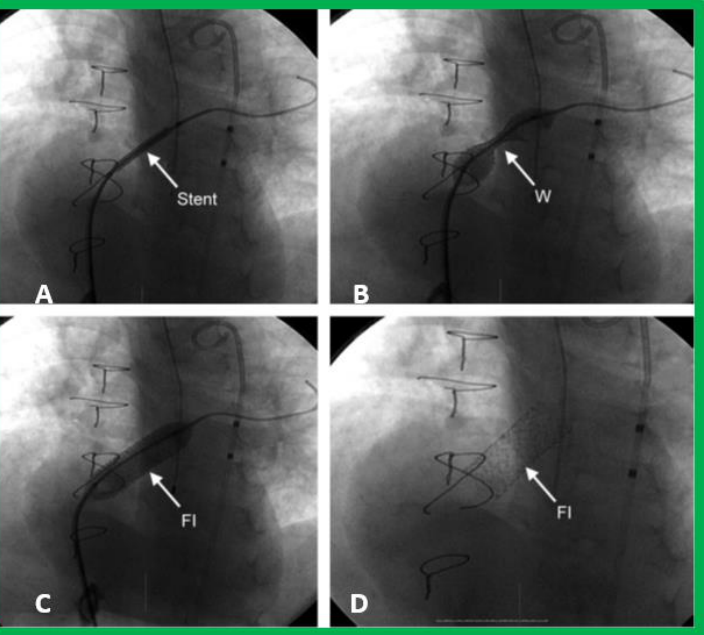
Figure 7. ( A ) to ( D ) : Selected cine frames while implanting the stent across a severely restrictive patent foramen ovale shown in Figure 5, illustrating the position of the stent prior to balloon inflation ( A ), during balloon inflation with a waist (W) of the balloon ( B ), and at the conclusion ( C ) of stent implantation. The position of the fully inflated stent (FI) before ( C ) and following ( D ) removal of the balloon is shown. Sternal wires from prior surgery are seen, but not labeled. PT, marker pigtail catheter. Modified from [4].